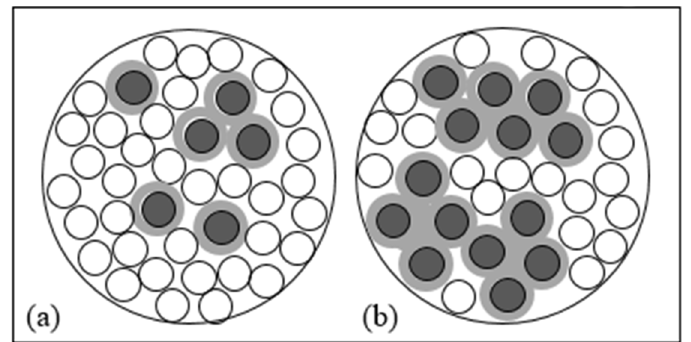
Figure 1. Schematic representation of a cross-section area of a granular reactive mixture composed of ZVI particles (grey circles) including iron corrosion products (light grey circles) and admixing agent particles (white circles), considering a minor ( a ), or major ( b ) ZVI content per unit volume.